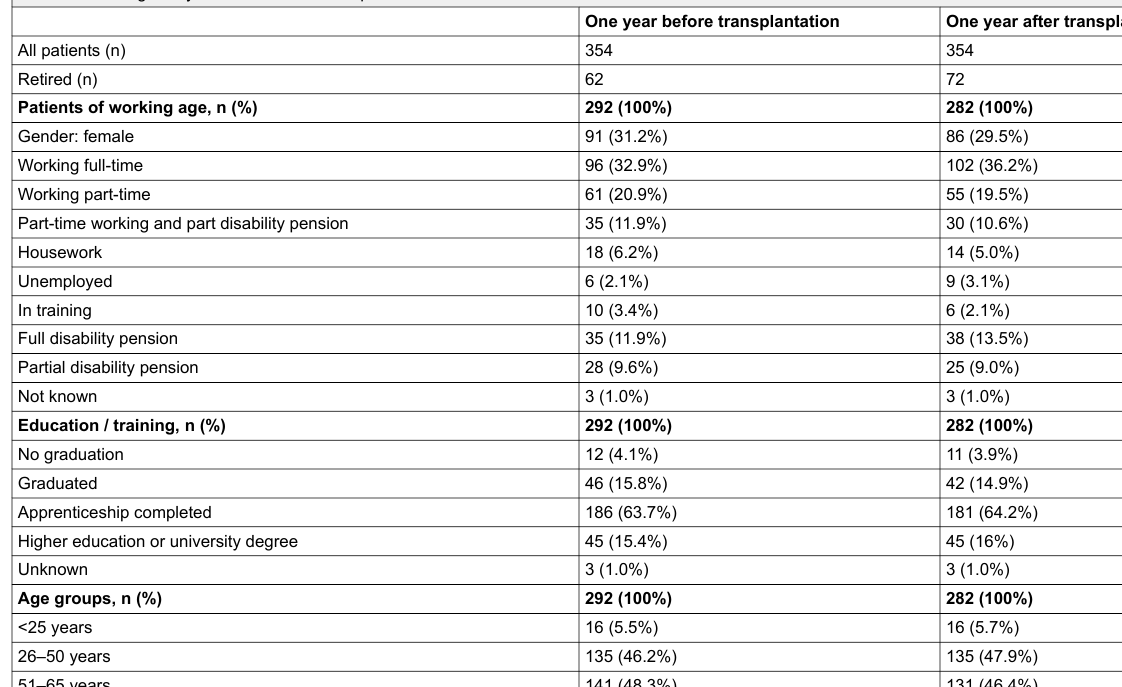
Table 2: Working ability before and after